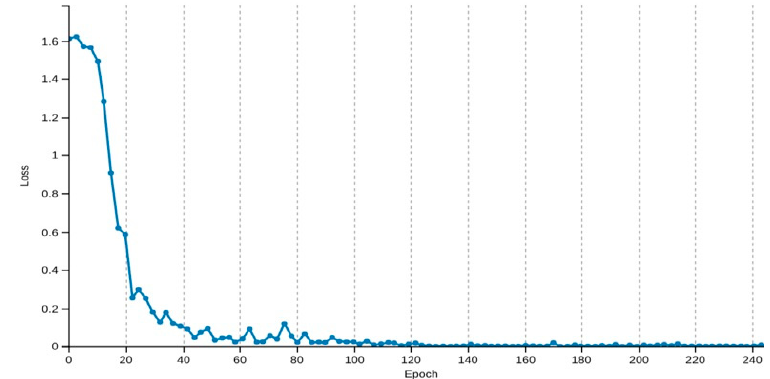
Figure 8. Graph representing loss vs. number of epoch during the training of the neural